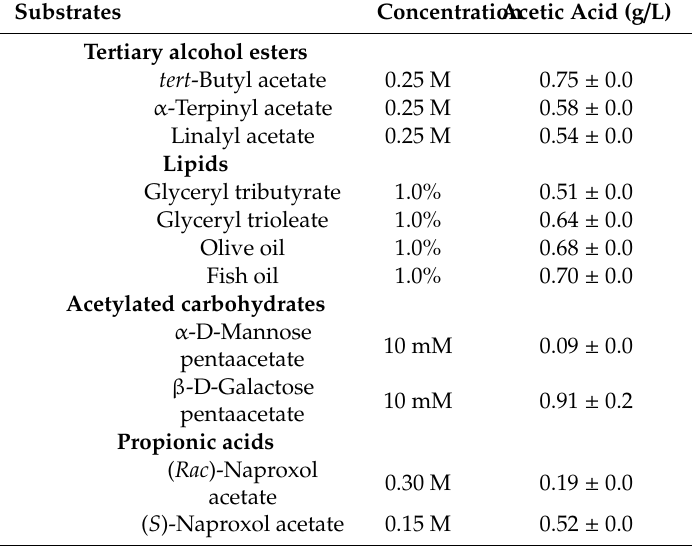
Figure 4. Enzymatic properties of Ha HSL. Stability of Ha HSL toward detergents was studied using various concentrations of ( A ) Triton X-100 and ( B) Tween 20. ( C ) Freezing–thaw experiments of Ha HSL for 20 cycles. ( D , E ) A pH shift assay was performed for glyceryl esters (glyceryl tributyrate (GTB) and glyceryl trioleate (GTO)), and oils (olive oil (O.O.) and fish oil (F.O.)). ( F ) Fluorescence intensity due to the hydrolysis of 4-methylumbelliferyl (4 MU)-acetate and -phosphate by Ha HSL. Table 1. Acetic acid release assay of Ha HSL toward various acetate compounds. The amount of acetic acid released from the hydrolysis of di ff erent acetate-containing substrates by Ha HSL were measured. The absorbance of acetic acid was detected at 340 nm. All experiments were performed at least in